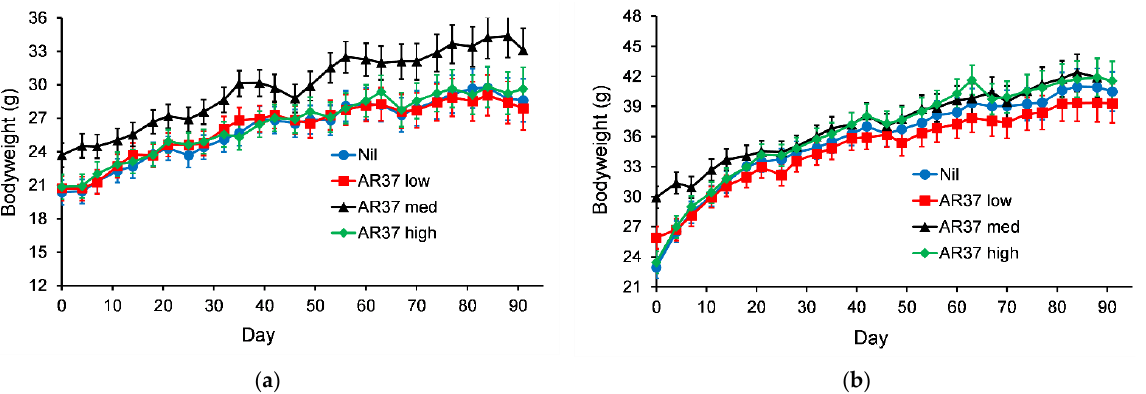
Figure 2. Bodyweight of female mice ( a ) or male mice ( b ) fed a diet containing AR37 endophyte- infected seed (0, 7.5, 15 or 30% for nil, low, med and high, respectively). The error bars are the standard error obtained from the fitted model.